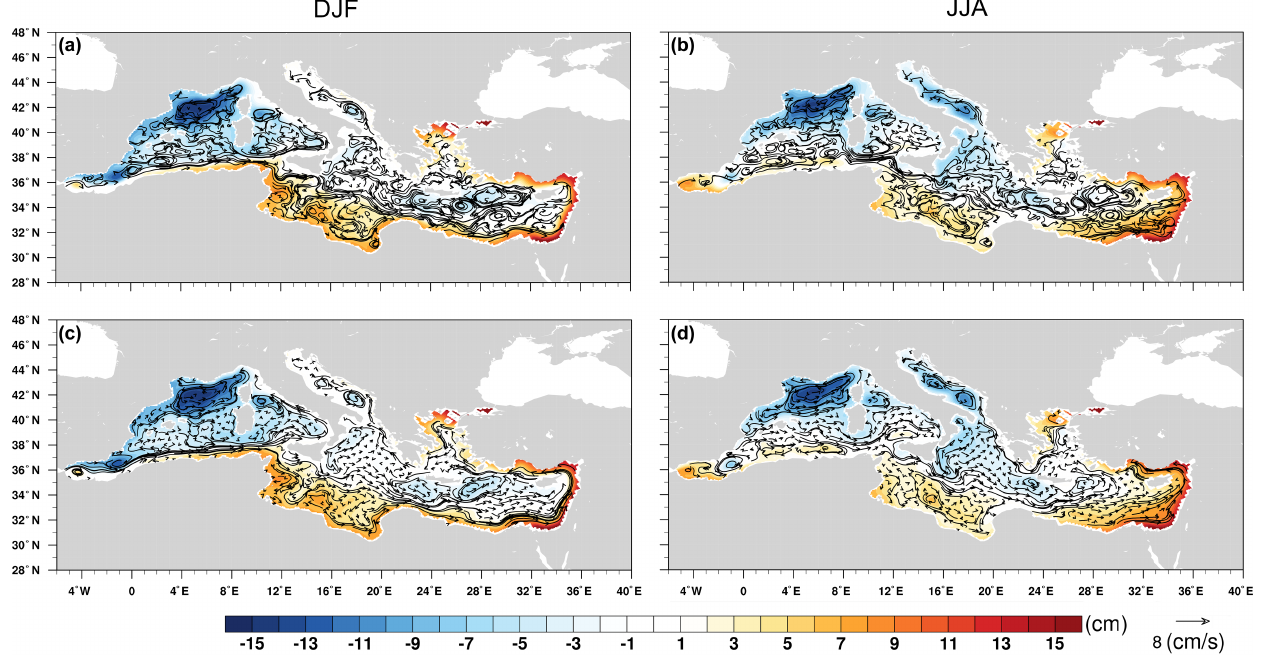
Figure 2. Winter (a, c) and summer (b, d) averages of present-day geostrophic circulation (vectors, cms − 1 ) and sea-surface height (SSH, colors, cm) from AVISO (a, b) and ROM (c, d) . For comparison we use the 1993–2005 period, when both model and observed data are